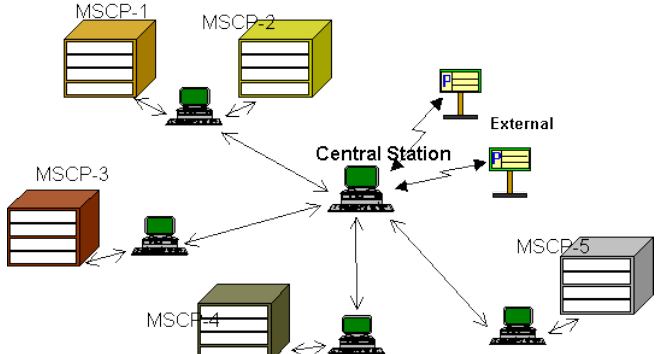
Figure 2. Architecture of e-Park solution linking agroup of Parks.(Tripod,